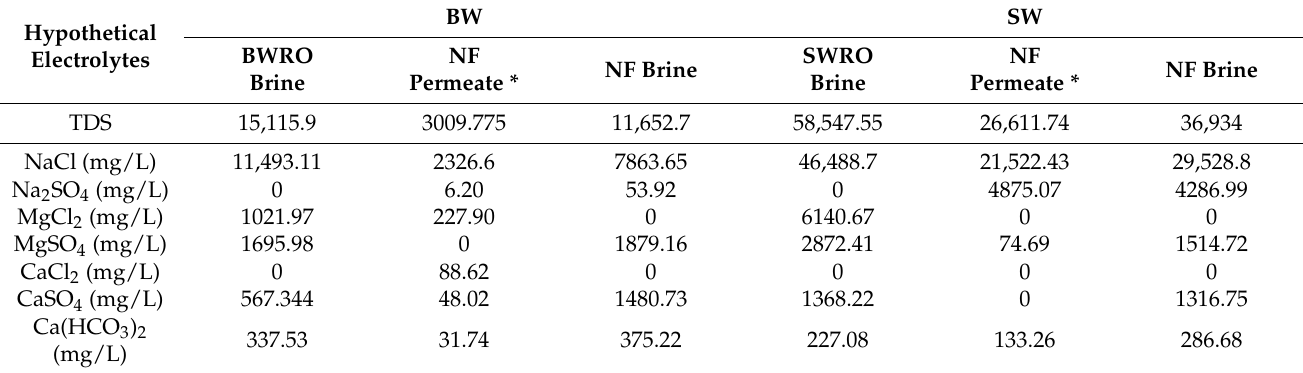
Table 5. Hypothetical ions (in mg/L) combination and their removal using NF